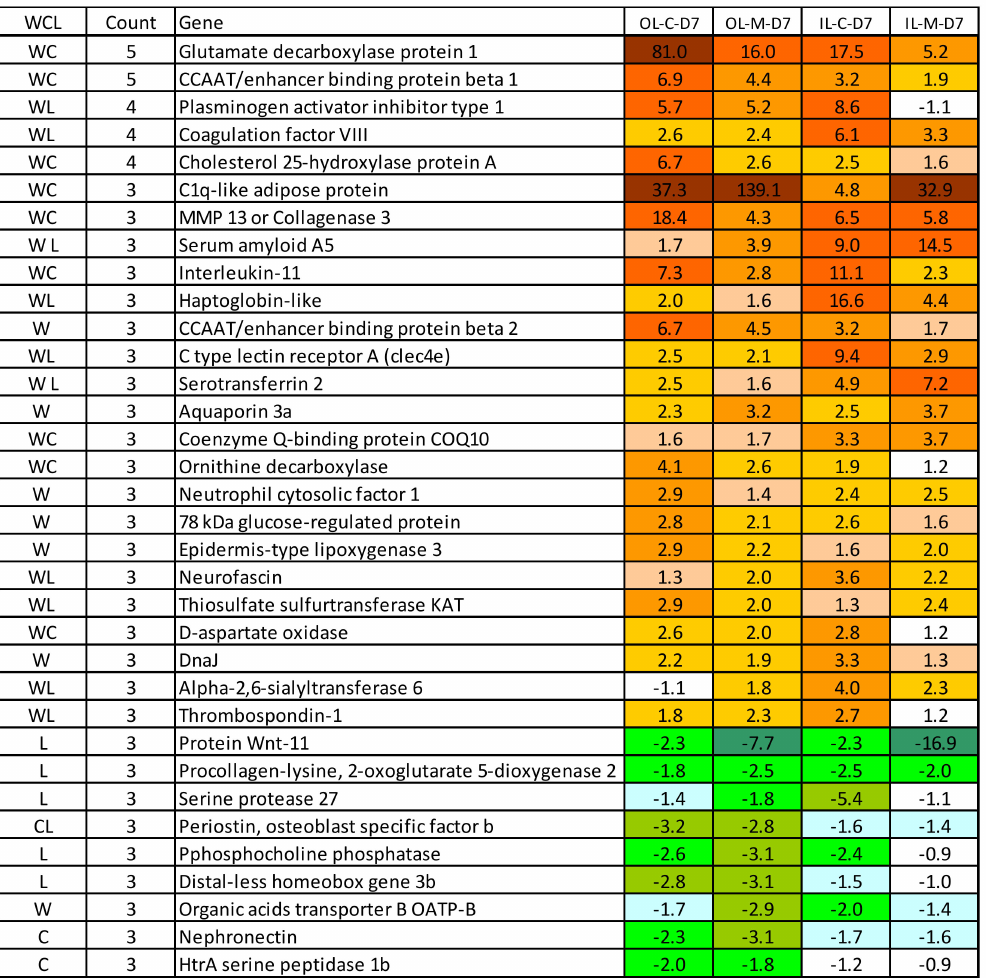
Figure 5. Gene markers of lice responses to lice in Atlantic salmon skin, data are folds to intact skin. Genes with expression differences in at least three of five data sets were selected. First column represent study with response, only stable responses for wound (W), cortisol (C) and difference between the skin layers (L). Second column—number of data sets with differential expression (maximum five). The last columns show the transcriptional response in the present study. Abbreviations: OL, IL—outer and inner layers, M, C—diets, D—days post-challenge (dpc). Red and green color denote up and down-regulation of the